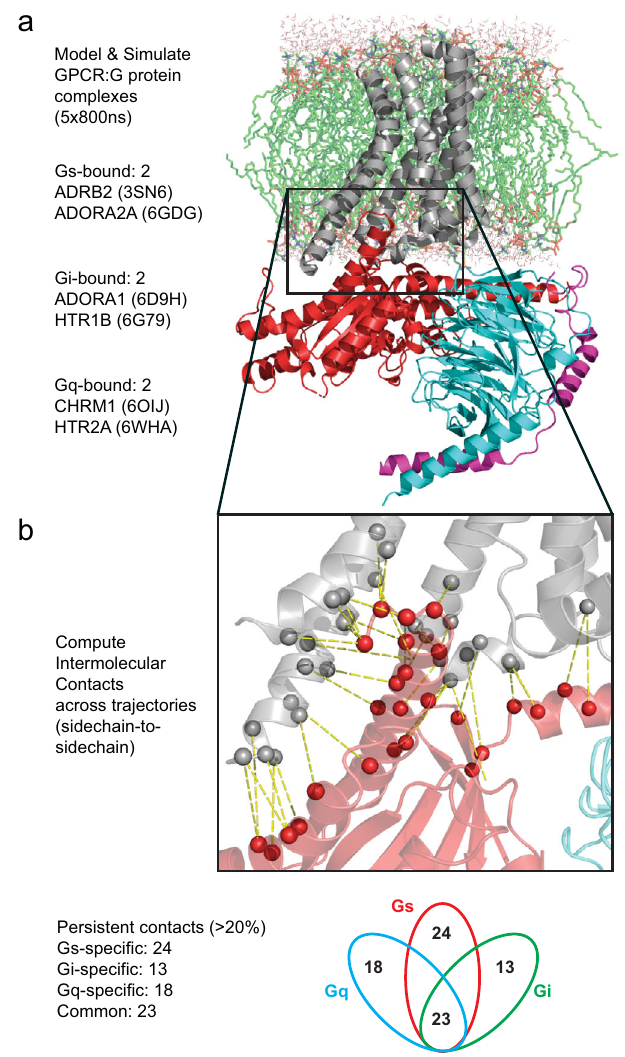
Fig. 2 | Work fl ow for extracting the spatiotemporal heat map for the residue contacts in GPCR:G protein interface. a We used six crystal and cryo-EM struc- tures of GPCR:G protein complexes to model the interactions of two Gs-coupled, two Gi-coupled, and two Gq-coupled GPCR:G protein pairs. Atomistic MD simula- tions were performed as fi ve replicates, each replicate extended to >800ns of simulation time for each of these GPCR:G protein complexes. The last 200ns window of each replicate was combined into a 1 μ s ensemble trajectory used for further analysis. Source data are hosted at GPCRmd.org. b The sidechain-to- sidechain intermolecularcontacts betweenGPCR and G α proteins werecomputed for each of the six complexes using the get_contacts.py method. We obtained 764 contactsforanalysisandidenti fi ed “ persistentcontacts ” asthosesampledfor>20% frequencyinoneorbothsystemsrepresentingeachclass(Gs,Gi,Gq).Amongthese persistent contacts, we identi fi ed a subset that appear uniquely in interactions of one G α protein family ( “ speci fi c contacts ” ) and those which are found across all of the G α protein subfamilies (Gs, Gi, and Gq; “ common contacts ”